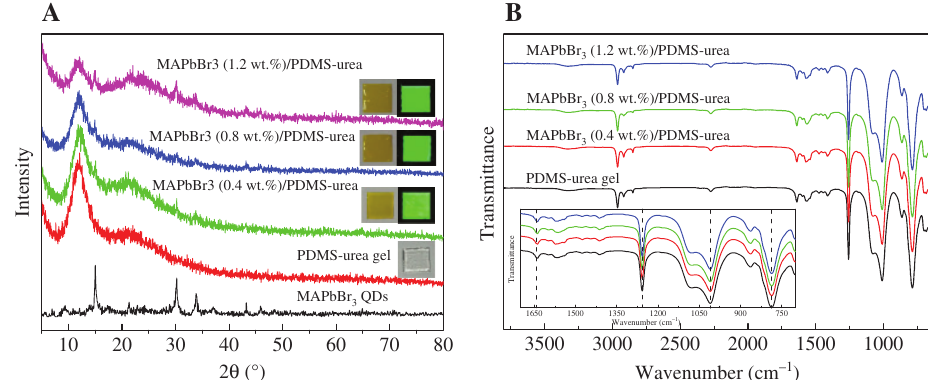
QDs, PDMS-urea gel and MAPbBr /PDMS-urea gels with different loading ratios of the MAPbBr Figure 2: (A) XRD patterns of the MAPbBr 3 3 QDs and (B) the FTIR spectra of the PDMS-urea gel and MAPbBr3/PDMS-urea composites with different loading ratios of the MAPbBr3 QDs. Inset: enlarged FTIR spectra in the wavenumber range of 1680–600 cm −1